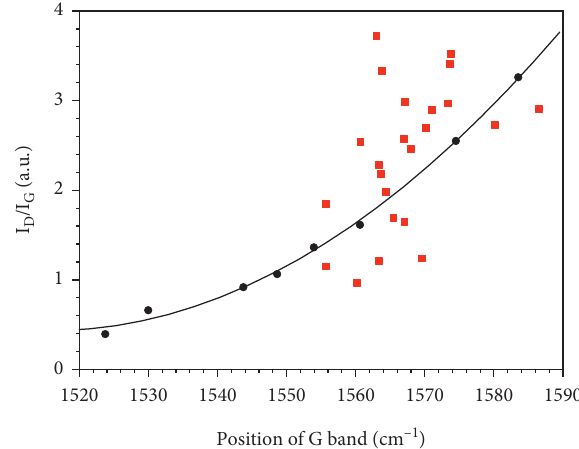
Figure 8: The ratio of the integrated areas of the Raman D and G bands ( I D / I G ) as a function of the G band position; , this work; , work from Tamor and Vassell